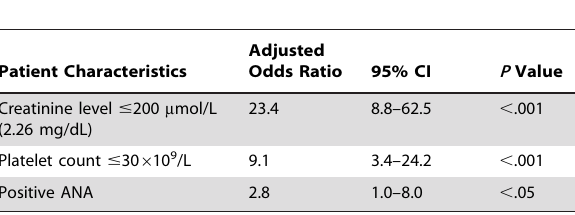
Table 4. Association Between Patient Characteristics and ADAMTS13 Deficiency Using Multivariate Analysis.